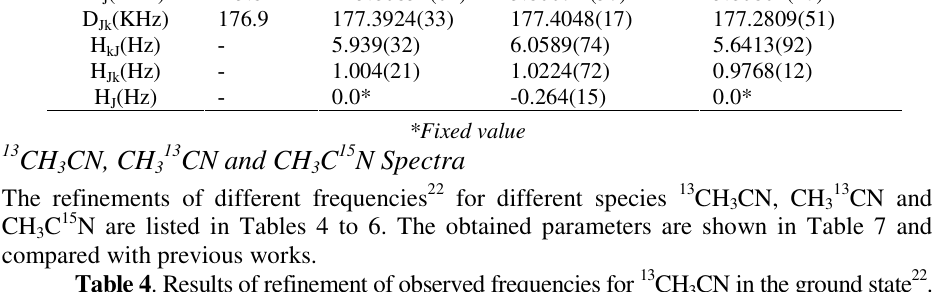
CN in the ground state 22 . 3